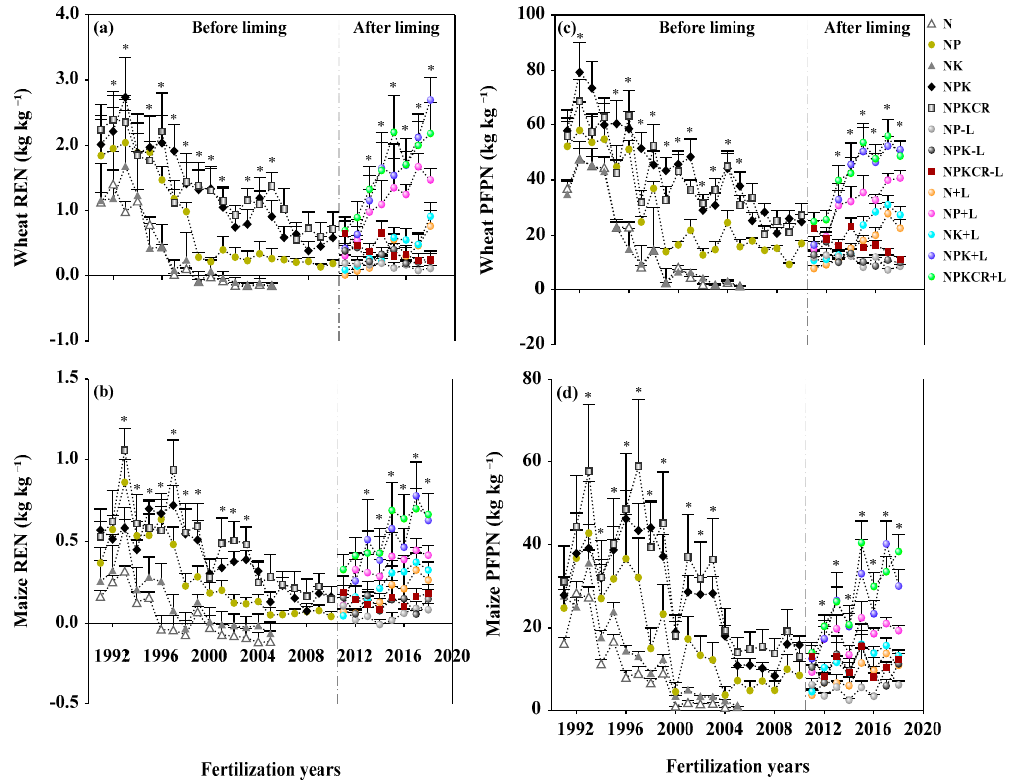
Figure 6. ( a ) Variation in N recovery efficiency (REN) of wheat; and ( b ) maize; ( c ) N partial factor productivity (PFPN) of wheat; and ( d ) maize, before and after L. Bars represents SD of means ( n = 4); *, denotes significant difference among the treatments at p ≤ 0.05 according to LSD test. N: nitrogen, NP: N and phosphorus (P), NK: N and potassium (K), NPK: N, P, and K, NPKC R : NPK plus crop residue (CR), − L: without lime application, +L: with lime application. NPKC R − L caused the averaged wheat RE N and PFP N values to decrease by 236% and 140%, while NPKC R +L increased them by 15% and 4%, respectively. For maize, NPKC